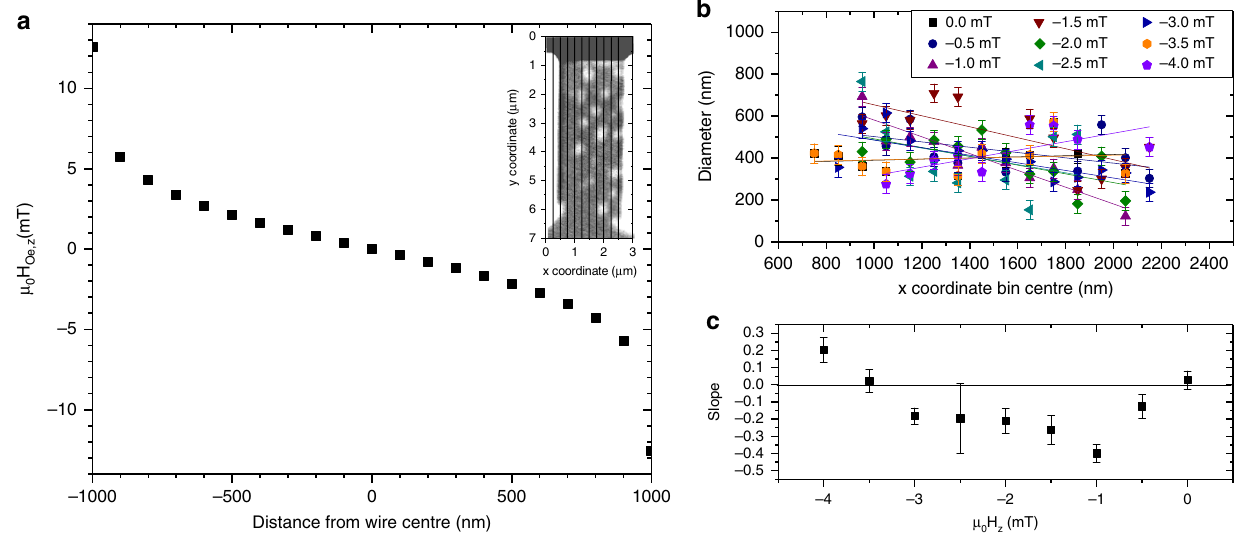
Fig. 5 Oersted fi eld across the wire generated by the current pulse. a Oersted fi eld, µ 0 H Oe,z calculated for a current in a rectangular wire with a current density of 5.6 × 10 11 Am − 2 , at a level 1 nm above the wire centre. b Average skyrmion diameter distributed across 50 nm segments (as illustrated in Fig. 5a inset) with respect to the applied fi eld (Lines show the best linear fi t). Error bars re fl ect the image resolution. c Slope versus fi eld of a line fi tted to the data shown in b . The line plotted is a guide to the eye. A negative slope re fl ects skyrmions shrinking in diameter as they traverse the wire from left to right. This is a consequence of the Oersted fi eld generated by the current fl owing through the wire. Error bars extracted from fi t.